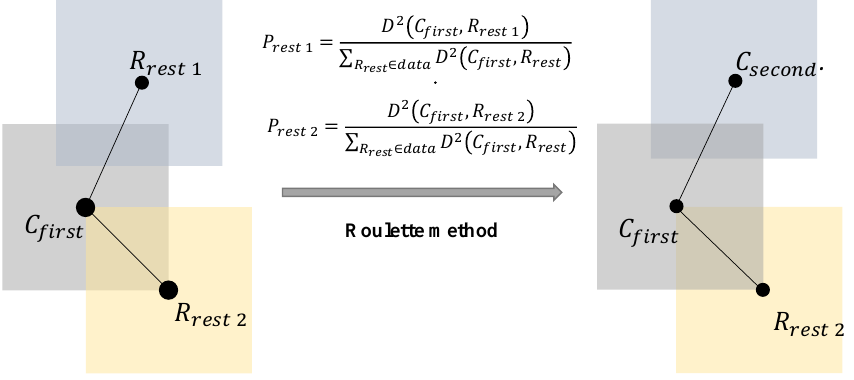
Figure 2. The process of generating the second cluster